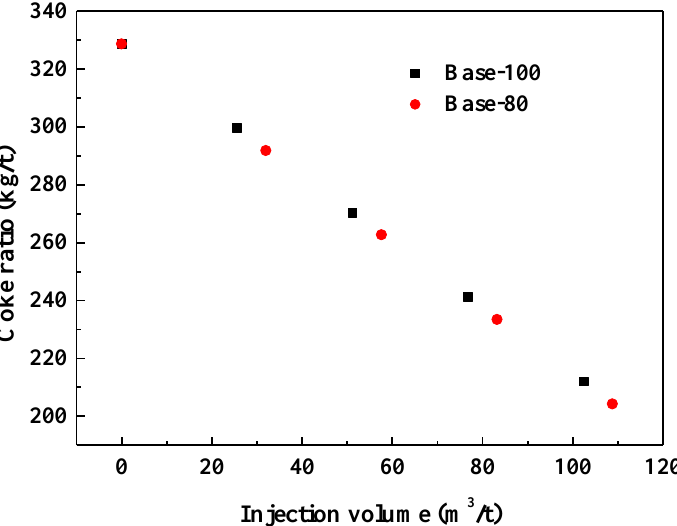
Figure 14. Effect of acceptable quantities of NG on the coke ratio under different oxygen enrichment rates.